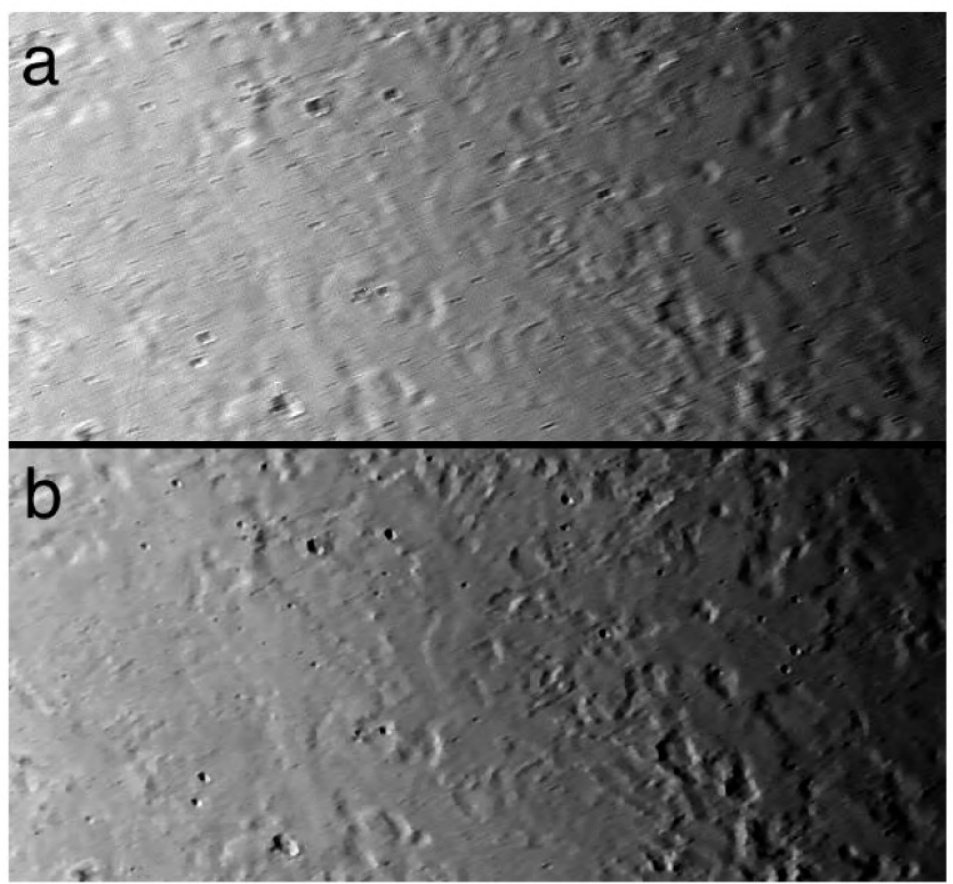
Figure 7. ( a , b ). Original ( top ) and desmeared ( bottom ) versions of Voyager 2 Triton image c1139607.img. Desmearing by T